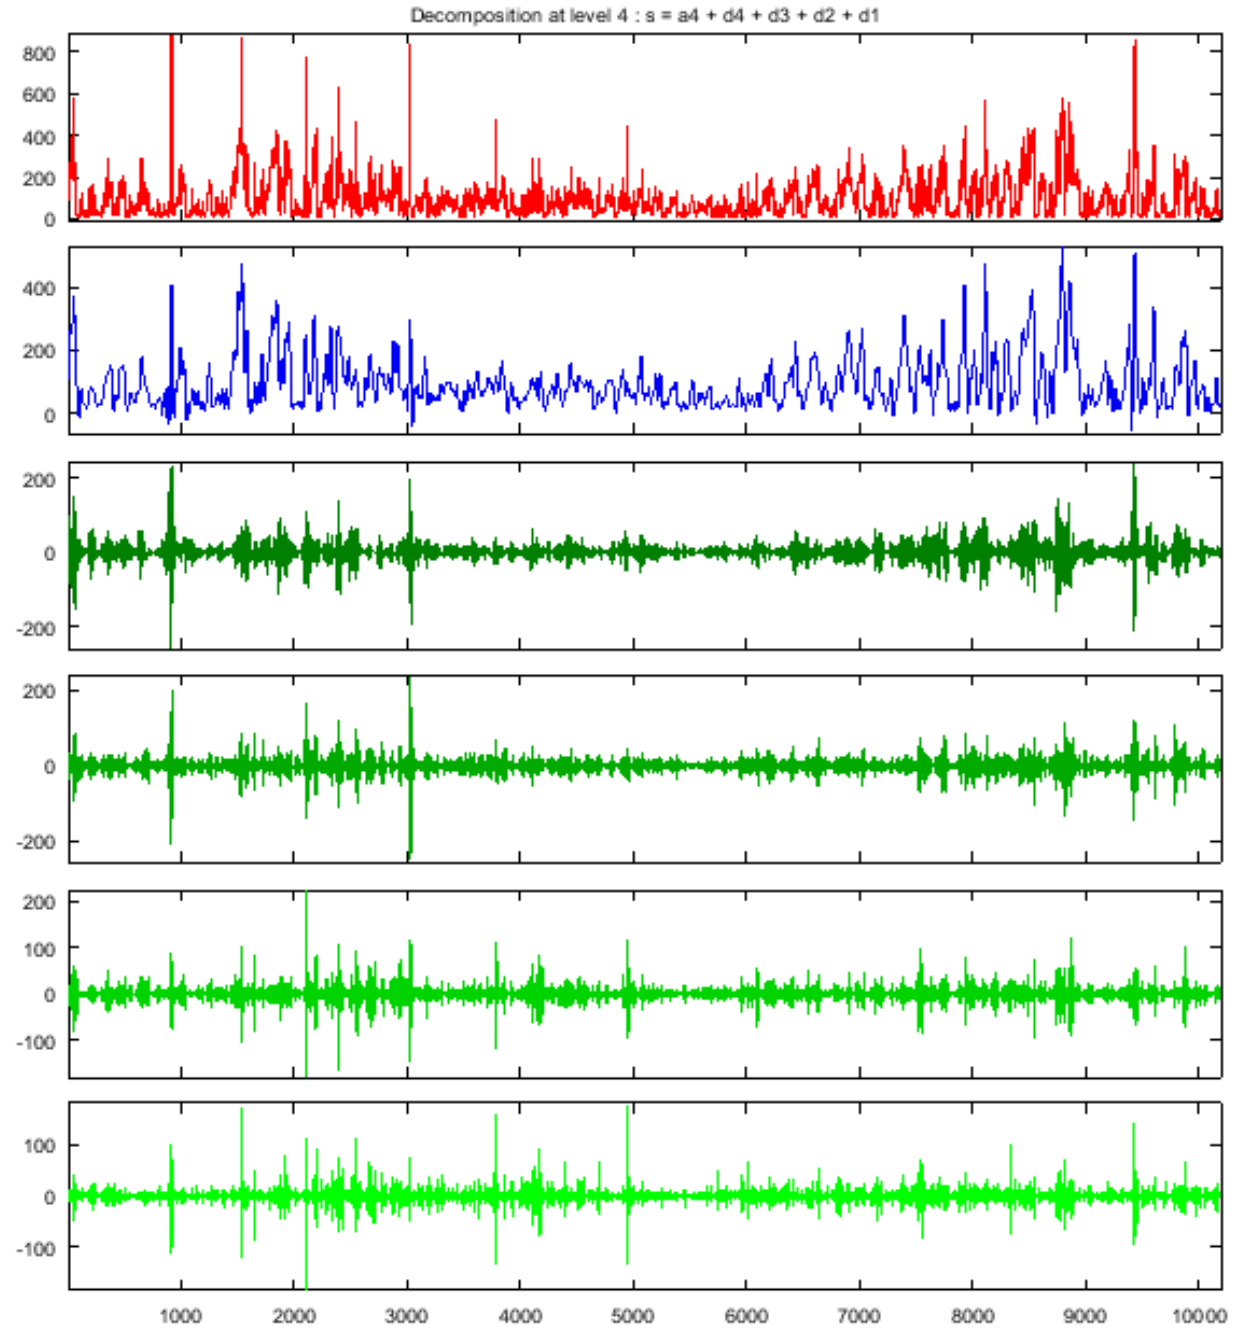
Figure 8. Decomposition of PM10 hourly data. The X-axis is hours, and the first part in each decomposed feature is a 4, d 4, d 3, d 2, d 1, from top to bottom,